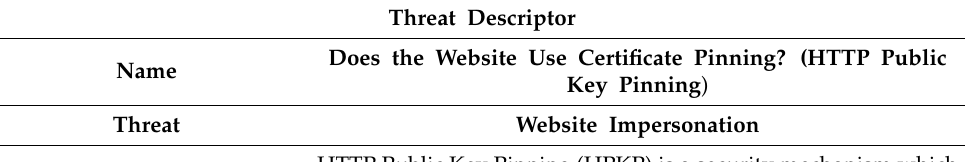
Table 1. An example Thread